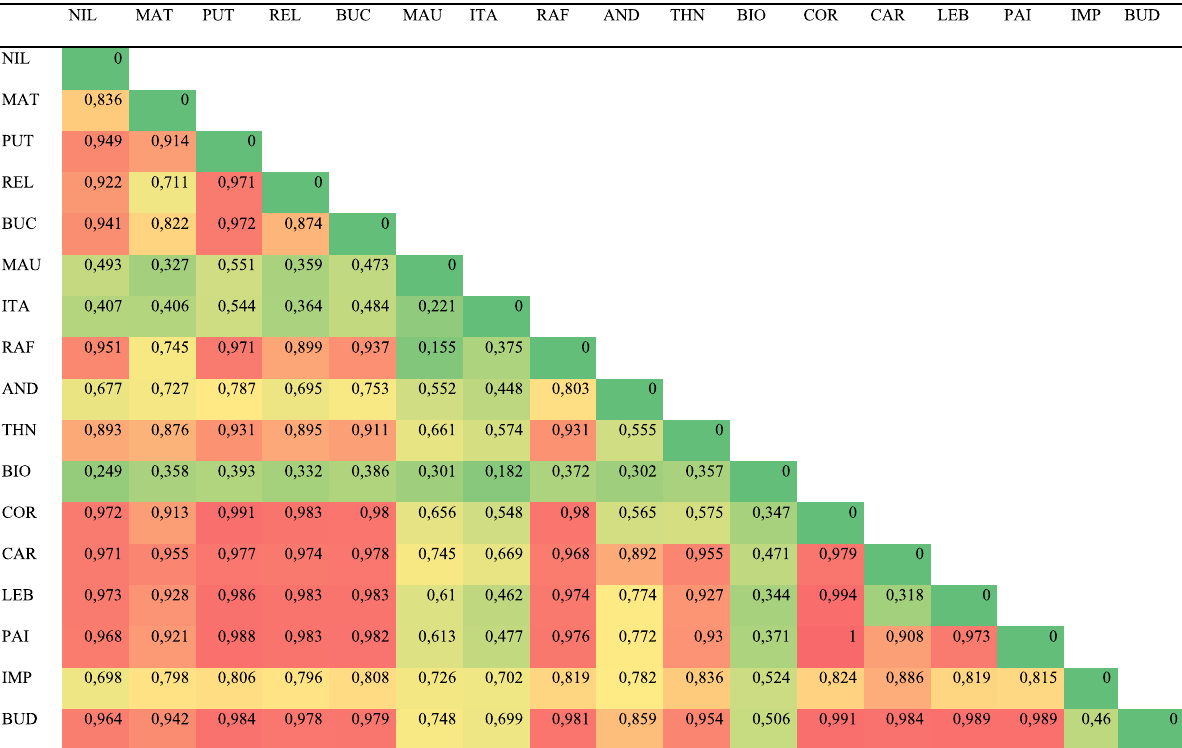
Table 2. Estimated Fst values for pairwise comparison between basins, throughout the distribution of P. pugnax . Basin codes as in Fig. 1 and Table 1. Basins are ordered latitudinally (North to the left). Green: lowest values; red: highest values. All Fst values are significant (p &;